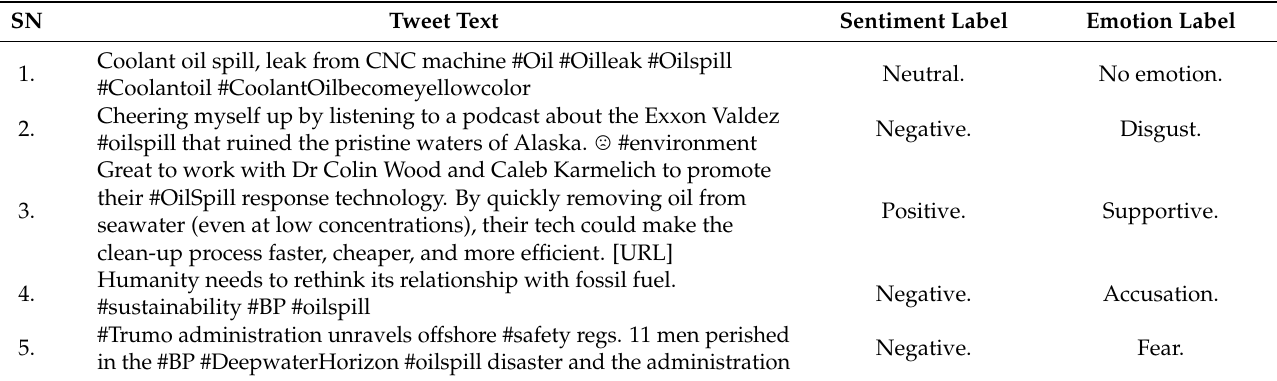
Table 1. Example tweets coded for emotion and